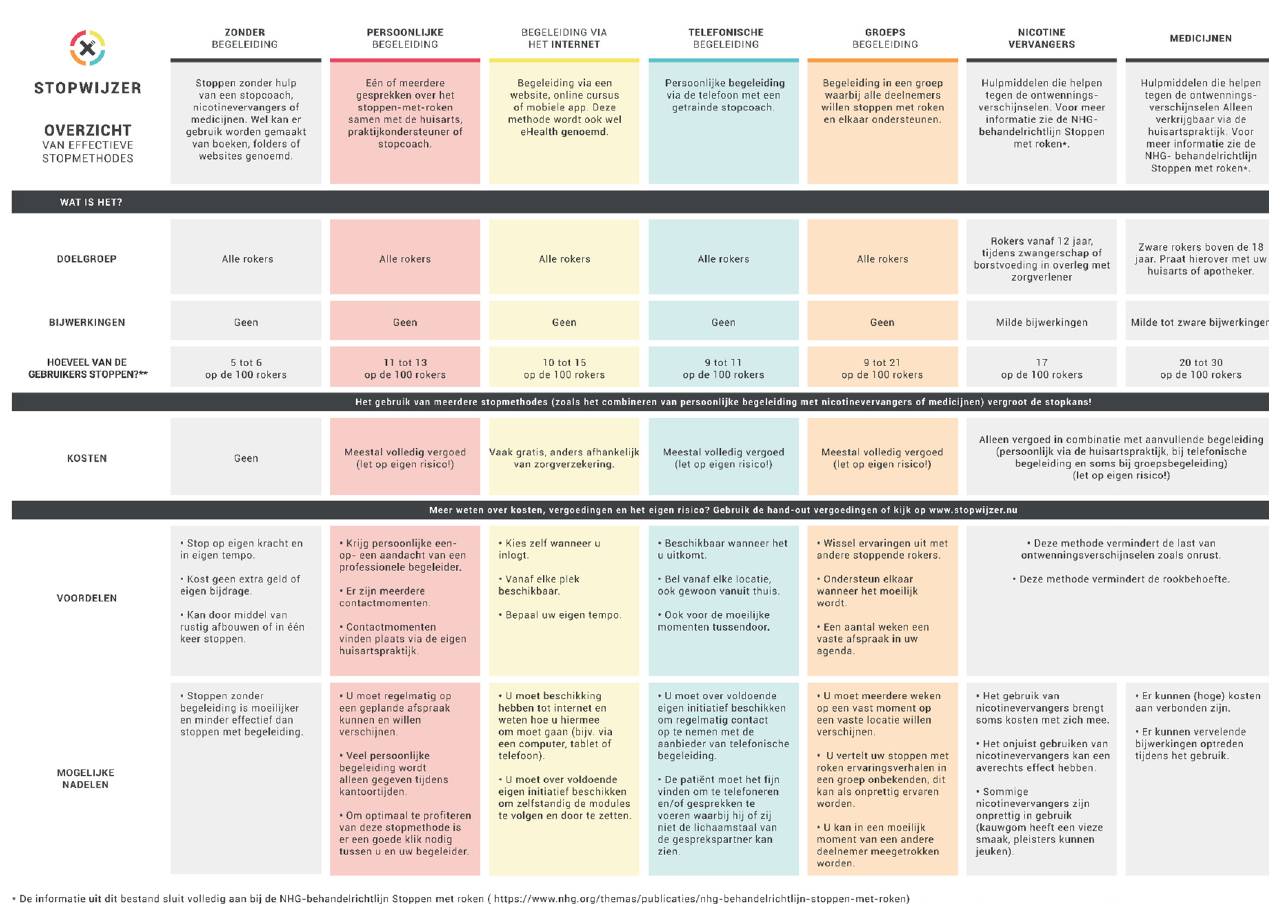
Figure 2. Decision overview (option grid). Figure 2. Excerpts from the DA